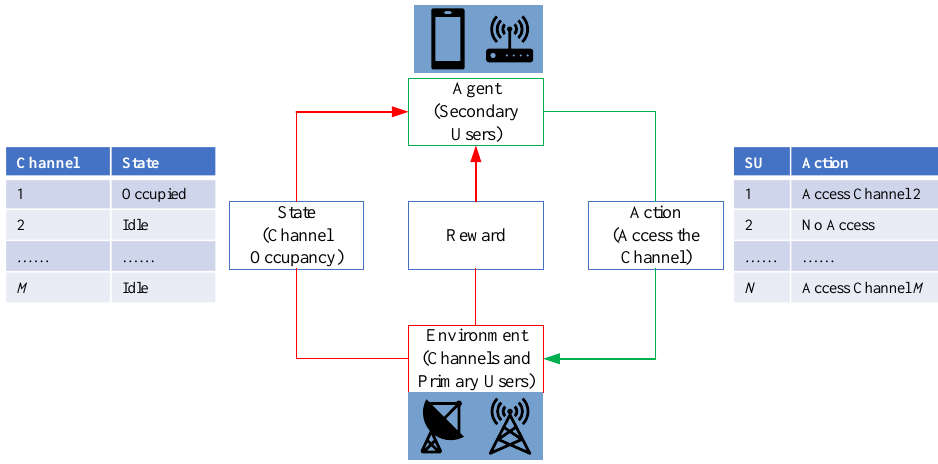
Figure 2. Principle of the reinforcement learning